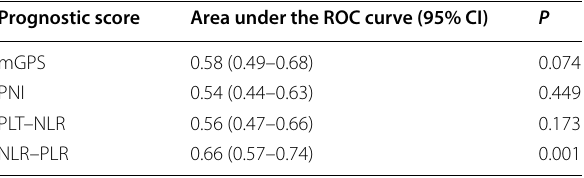
Table 4 Areas under the receiver operating characteris- tics (ROC) curve for four inflammation-based prognos- tic scores for predicting overall survival in 305 patients with stage I–II gastric cancer after